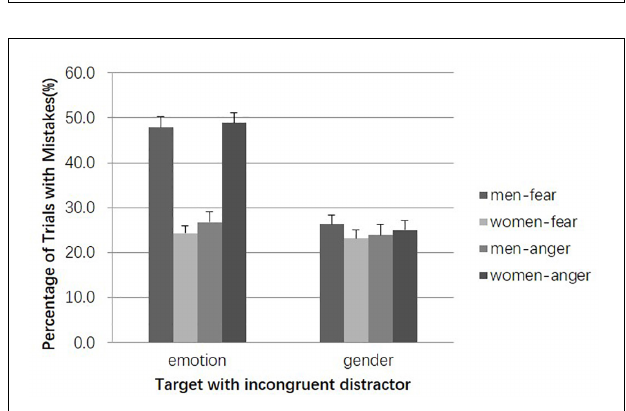
FIGURE 2 | Error rates in distractor-congruent condition. Error bars represent standard errors.